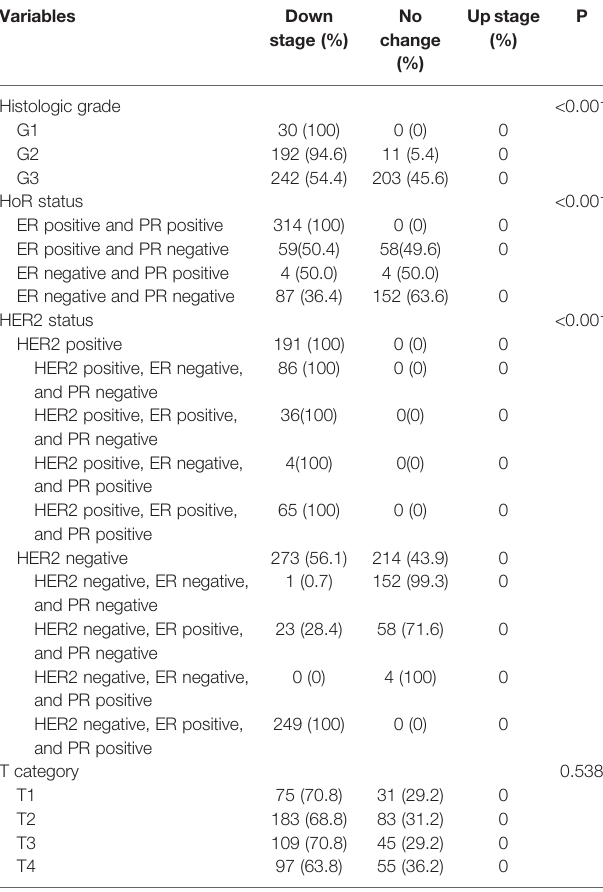
TABLE 2 | Comparisons of tumor characteristics among stage